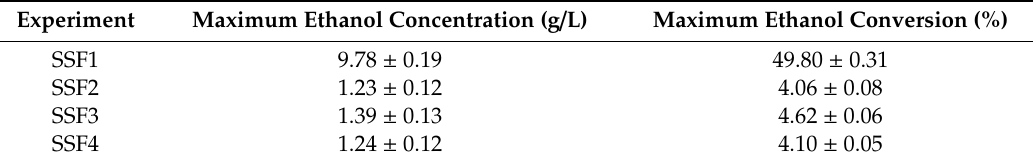
Table 3. Experimental results obtained in the SSF of untreated SSS and pretreated solid phases from selected pretreatments.